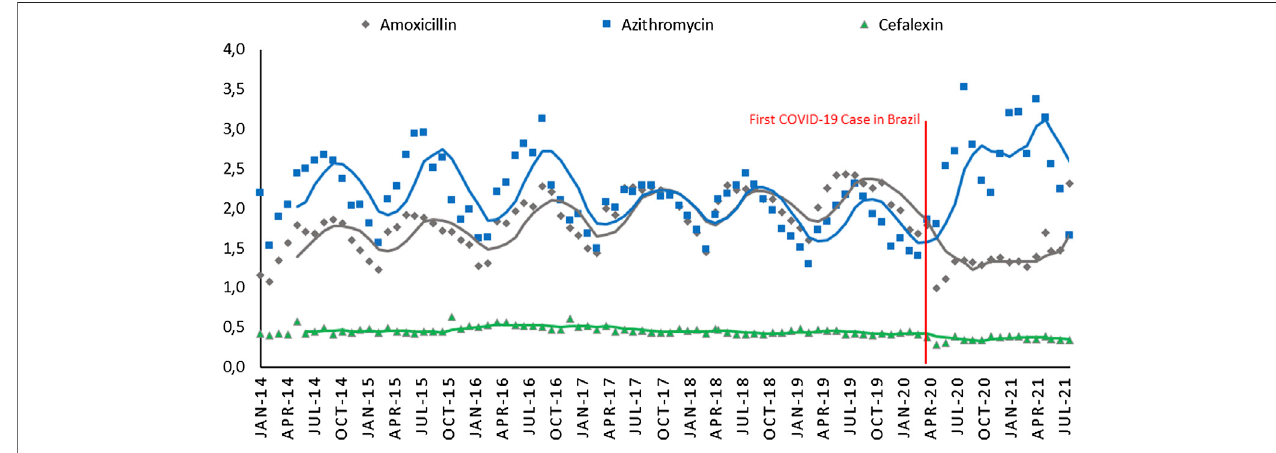
FIGURE 3 | Distribution in percentages of age groups of azithromycin consumption prescribed, in Brazil, between January 2014 and July 2021.